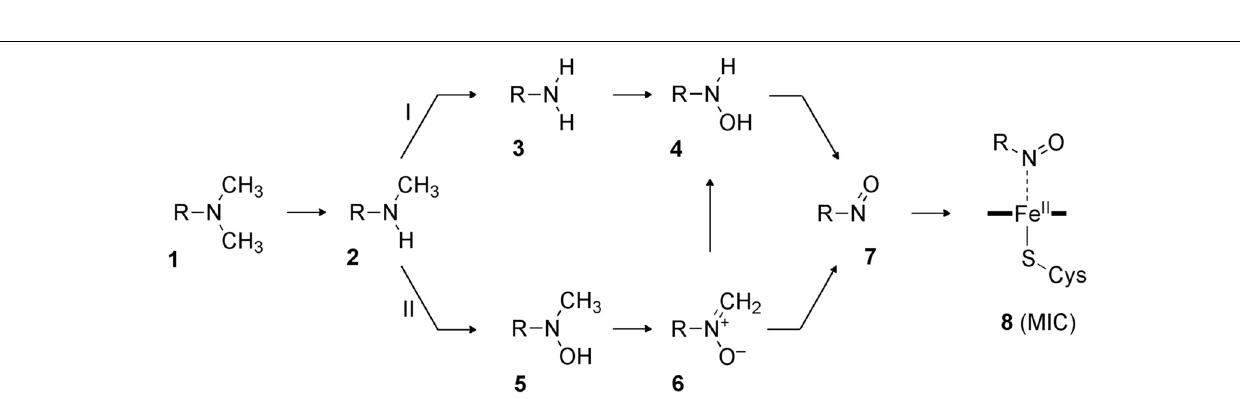
SCHEME 6 | Likely pathways of MIC formation starting from a tertiary amine (Hanson et al., 2010). Adapted from Hirao et al.